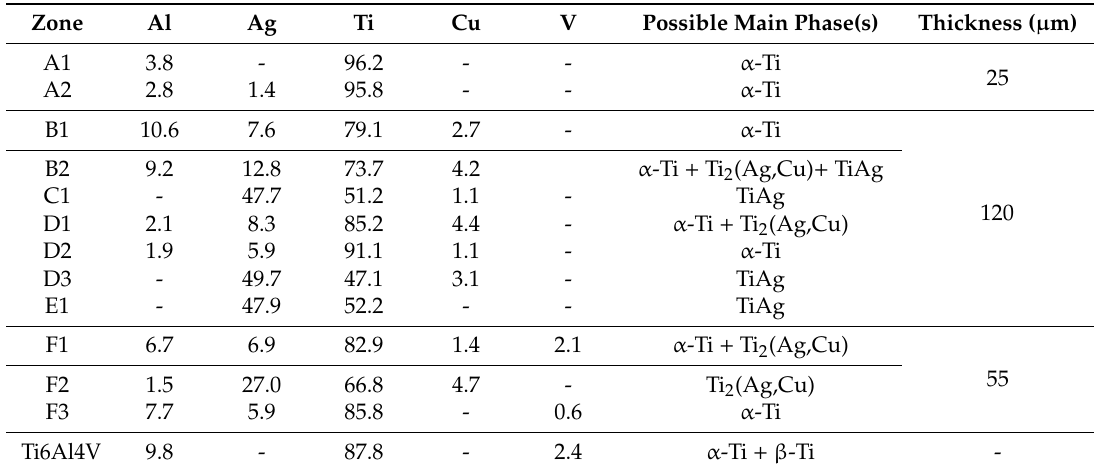
Table 2. EDS chemical composition (in %) of the zones of interest illustrated in Figure 6.